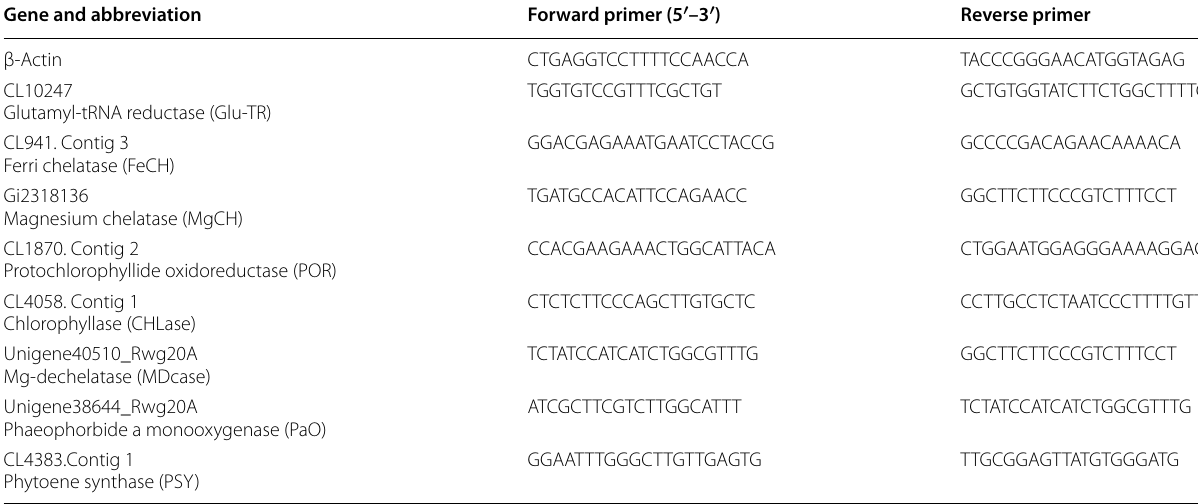
Table 1 Primer sequences used in real-time PCR analysis Gene and